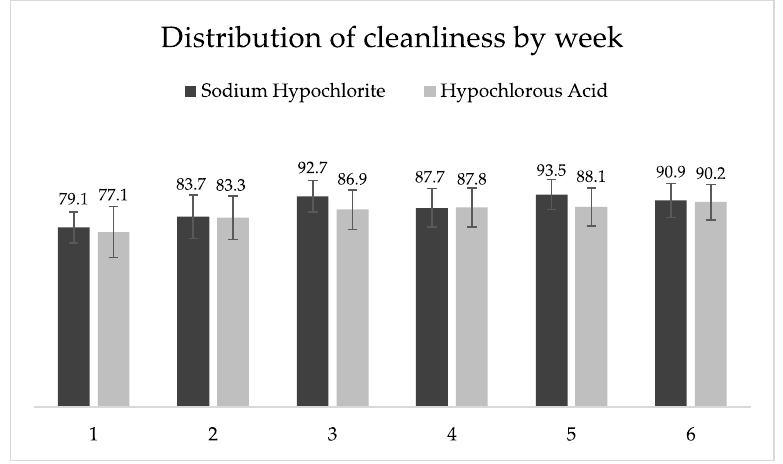
Figure 2. Percentage of microbiological cleanliness by treatment and by week. Table 3. Results from linear regression with week and cluster as fixed